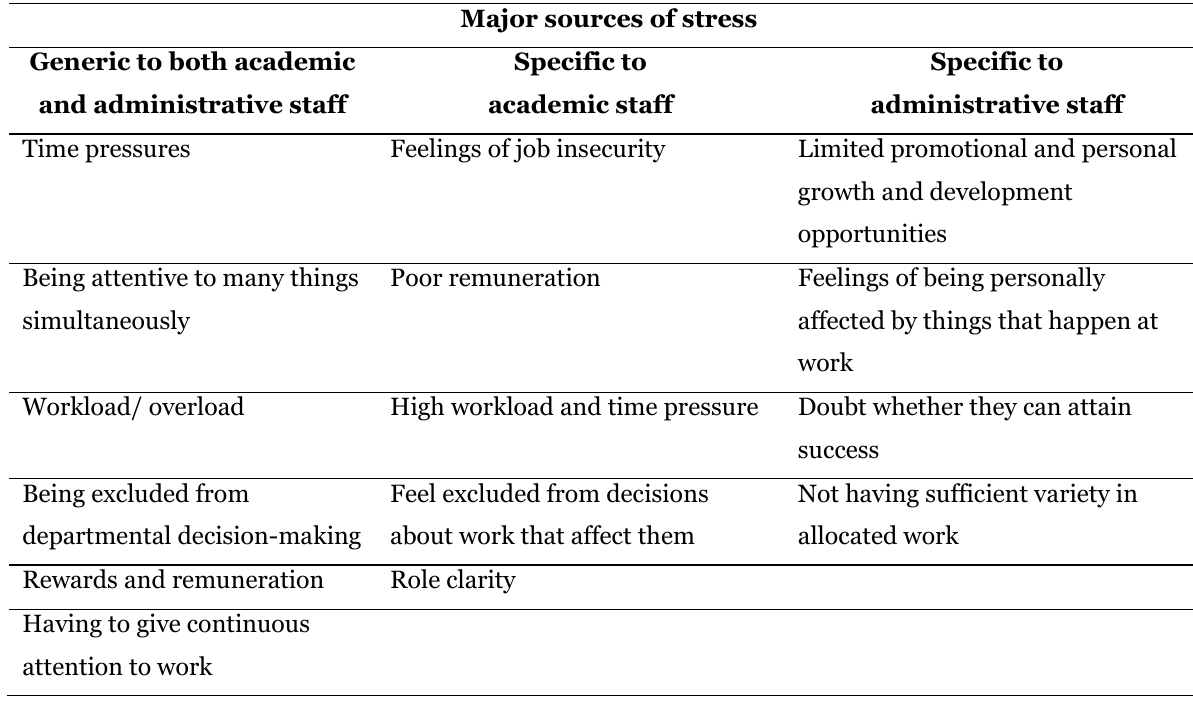
A Summary of the Major Qualitative Findings